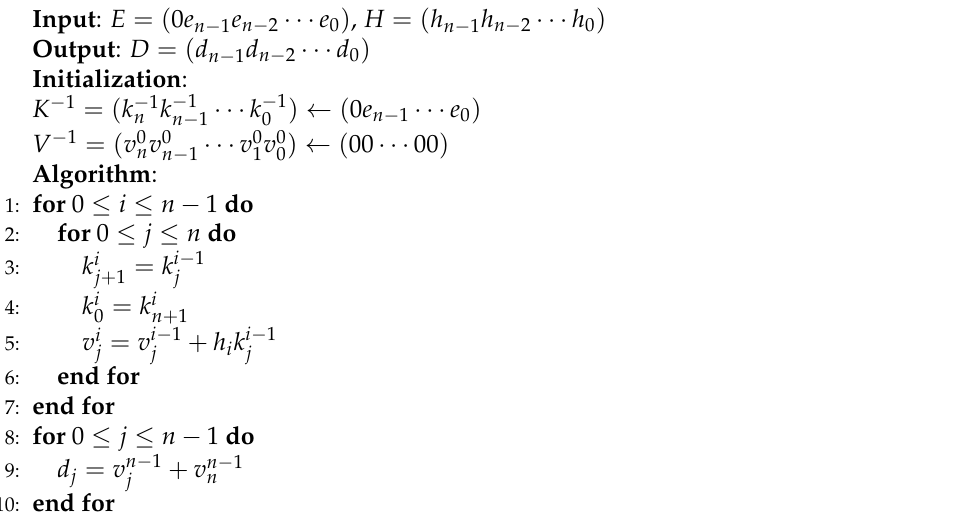
Algorithm 2 Finite Field Multiplication Algorithm in the bit-level